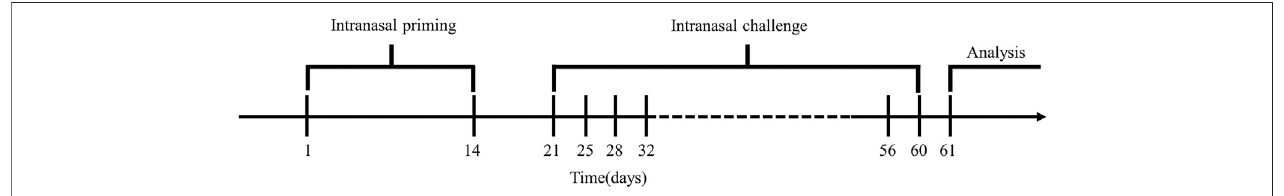
FIGURE 1 | Model building cycle. Mice were sensitized from day 1 to day 14, stimulated twice a week for six consecutive weeks from day 21 to day 60, and lung function and behavioral tests were performed on day